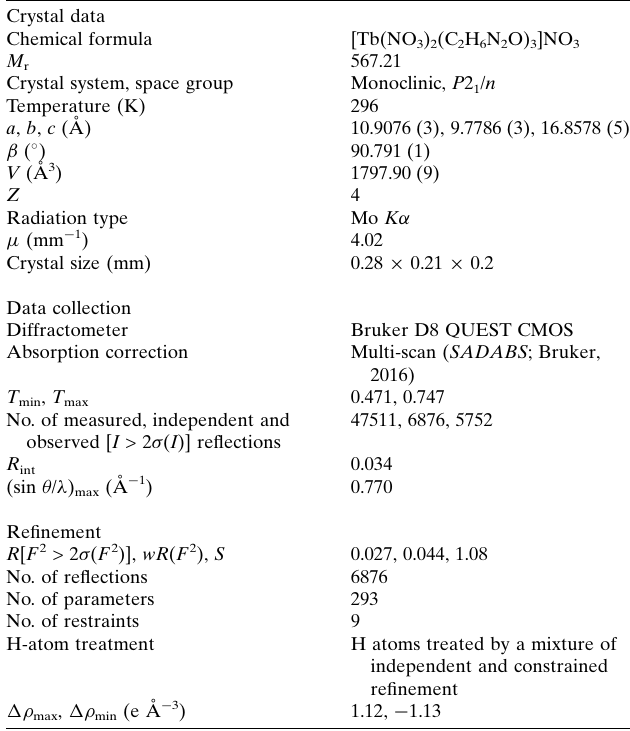
Crystal data Chemical